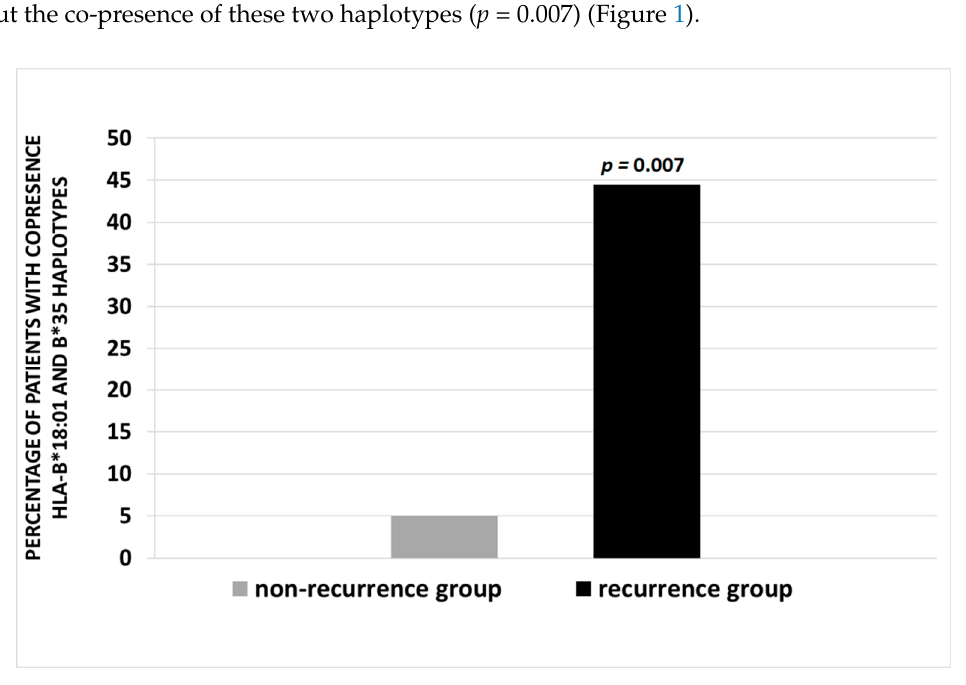
Figure 1. Percentage of patients with co-presence of HLA-B*18:01 and B*35 haplotypes in non-recurrence (NRG) and recurrence (RG) groups. A p value of <0.05 is considered statistically significant.